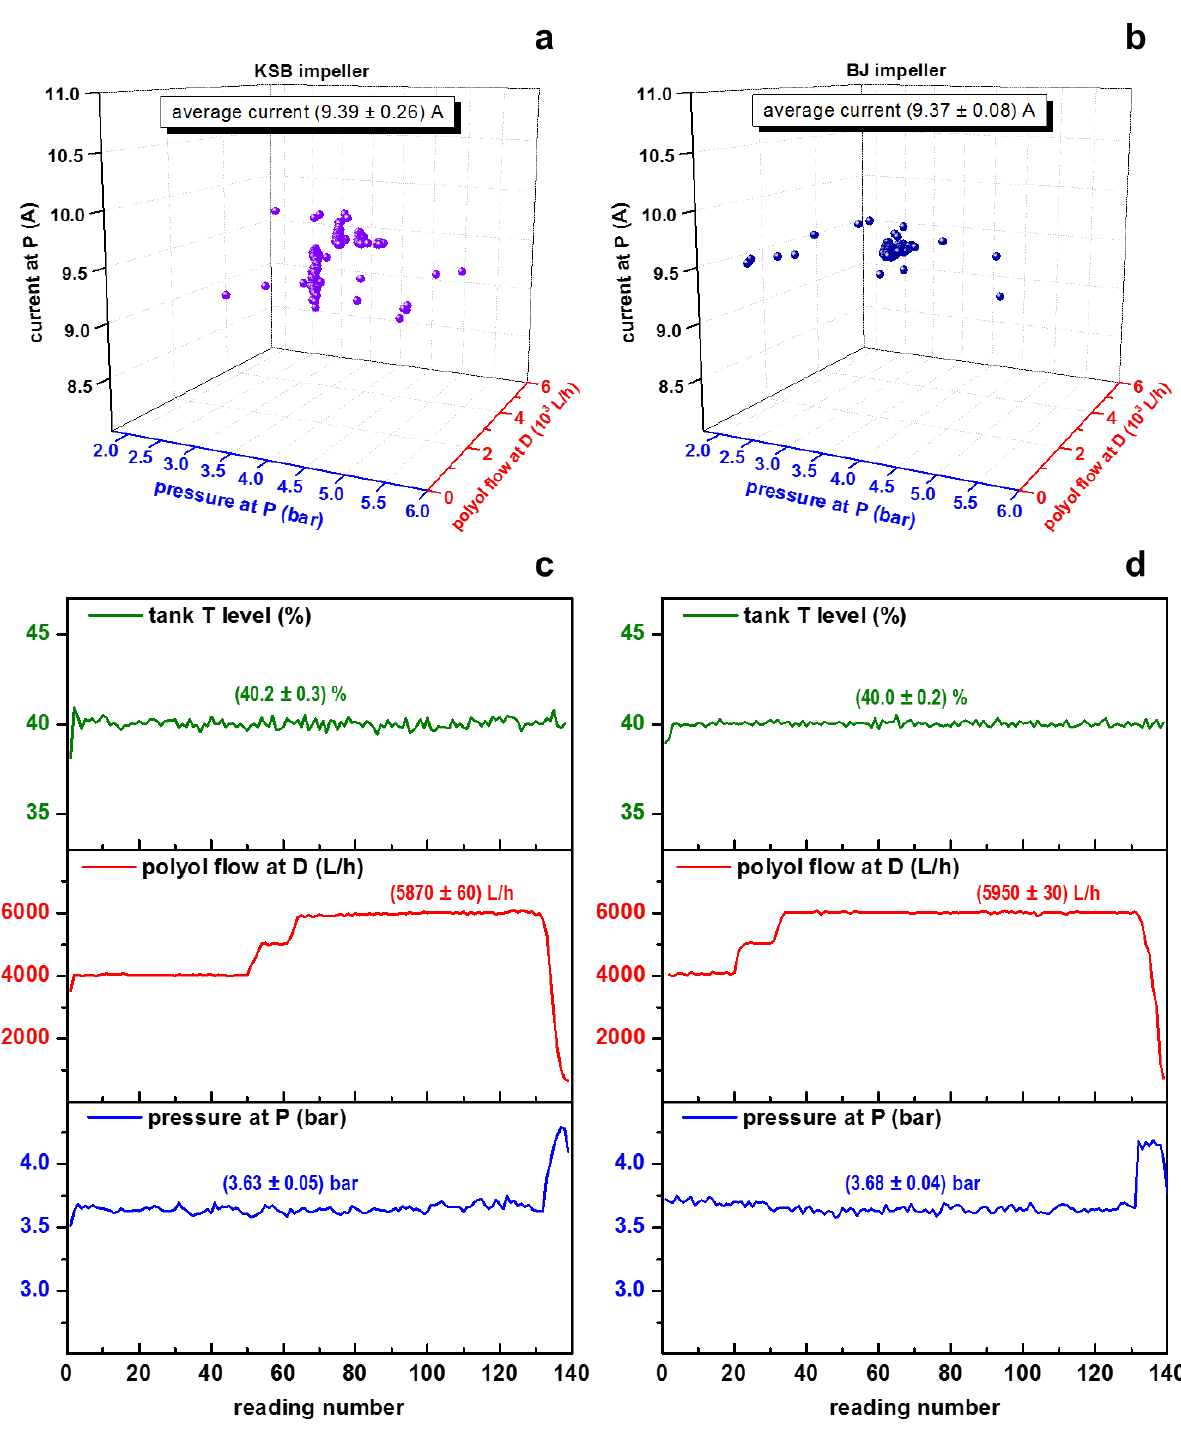
Figure 12. Recipe 2 . ( a , b ) Dependence of pump amperage (current) on pump pressure and polyol flow for two consecutive production cycles. ( c , d ) Tank level, polyol flow, and pump pressure, read continuously for a complete production cycle. KSB impeller ( a , c ), BJ impeller ( b , d ).